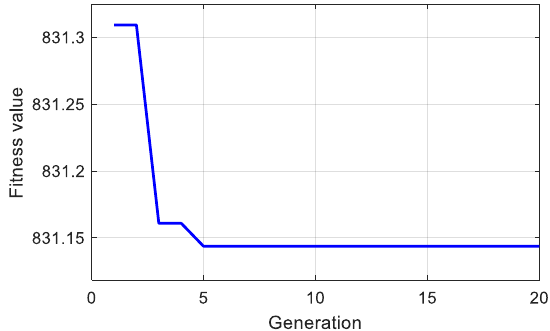
Figure 2. Fitness value of the 50 km/h constant radius test.